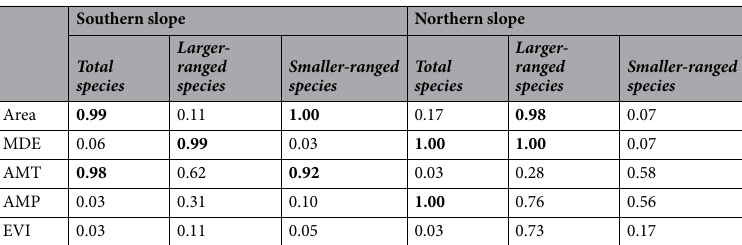
Table 2. Impact factors for each explanatory factor per gradient. The impact factors are the sum of the Akaike weights for each model including the explanatory factors across the whole model set. The bold values represent the factors with strong support (larger than 0.80) across all 31 models. Larger-ranged species: the 50% of species with ranges above the median range size; Smaller-ranged species: the 50% of species with ranges below the median range size; MDE: mid-domain effect; AMT: annual mean temperature; AMP: annual mean precipitation; EVI: enhanced vegetation